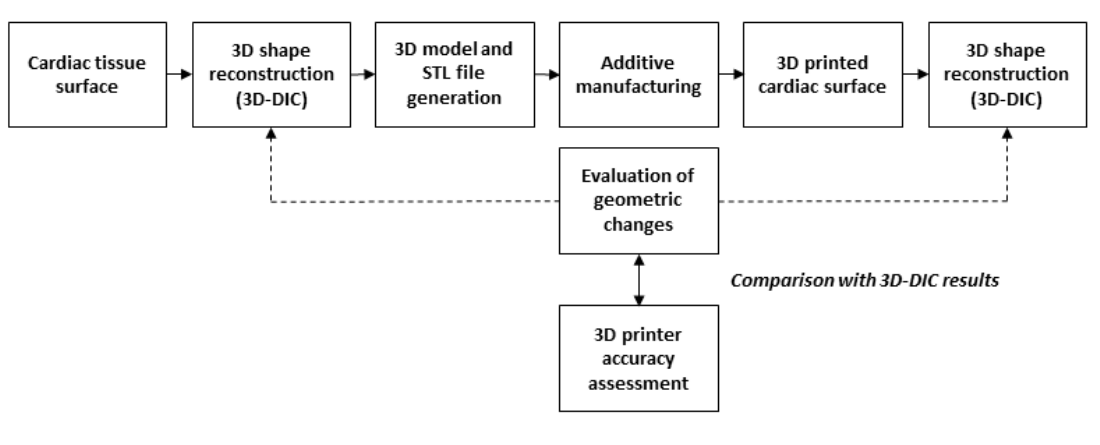
Figure 1. Outline of the study.